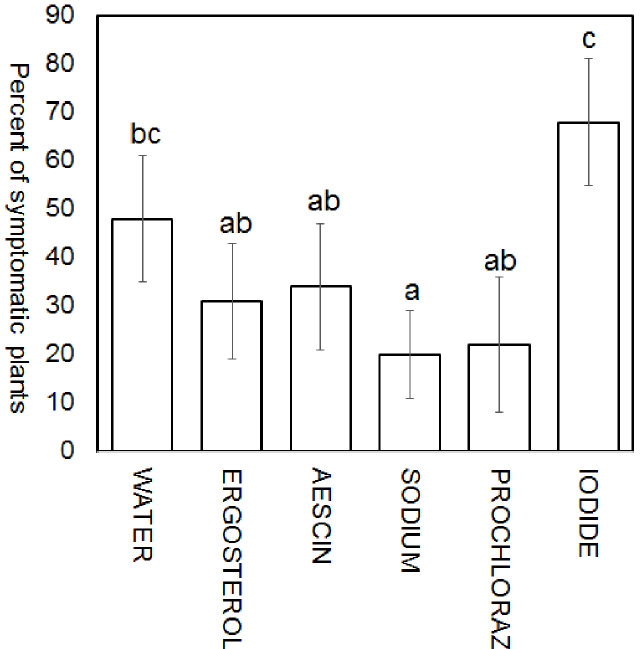
Fig 2. Percentage of F . culmorum -infected plants in different treatments with cultivar Bohemia. Two hundred inoculated seeds were evaluated for each treatment solution (water [control], ergosterol, aescin, sodium bicarbonate, prochloraz and potassium iodide). Error bars indicate 95% confidence intervals around the mean.